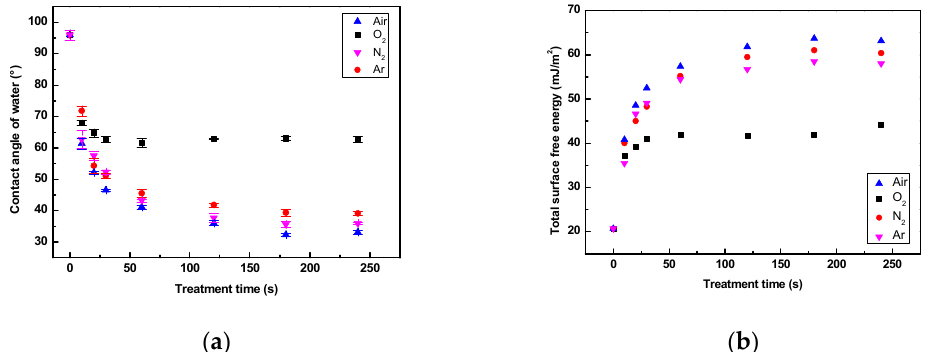
Figure 2. ( a ) Contact angle of water and ( b ) the total surface free energy as a function of treatment time for PU treated using air, O 2 , N 2 , and Ar plasma.